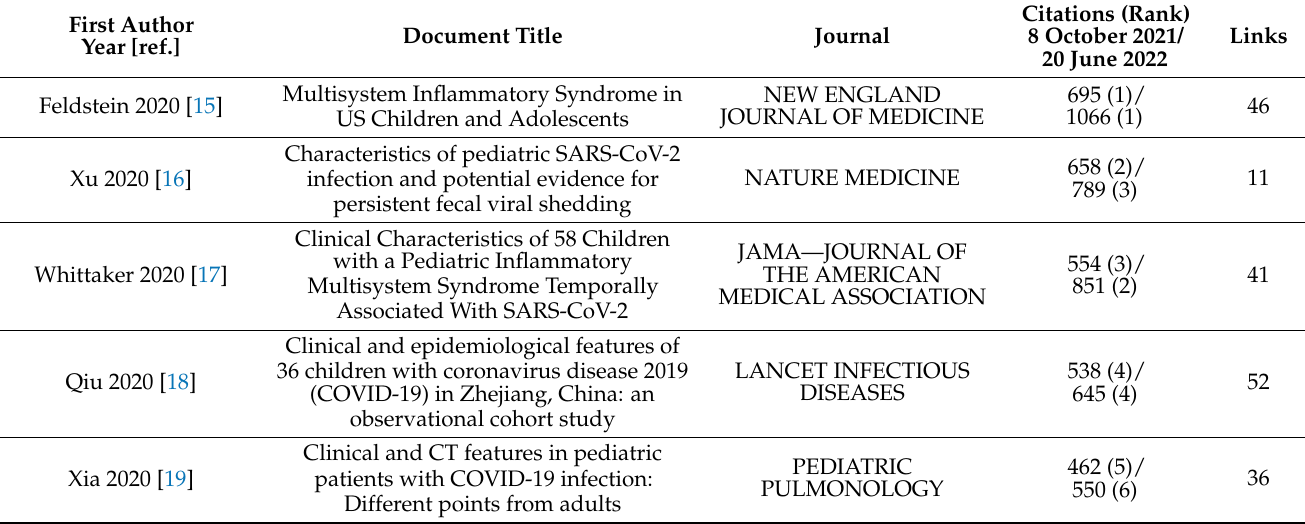
Table 3. Top 20 highly cited